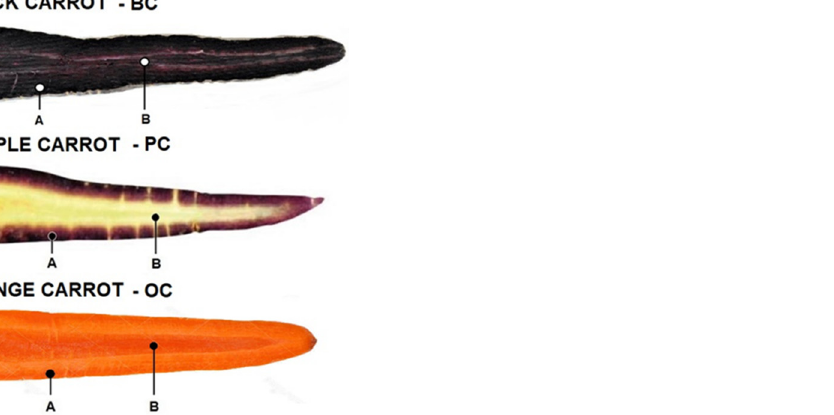
Figure 1. Longitudinal sections of differently coloured carrots. A and B indicate the phloem (cortex) and xylem (core) tissues, respectively.